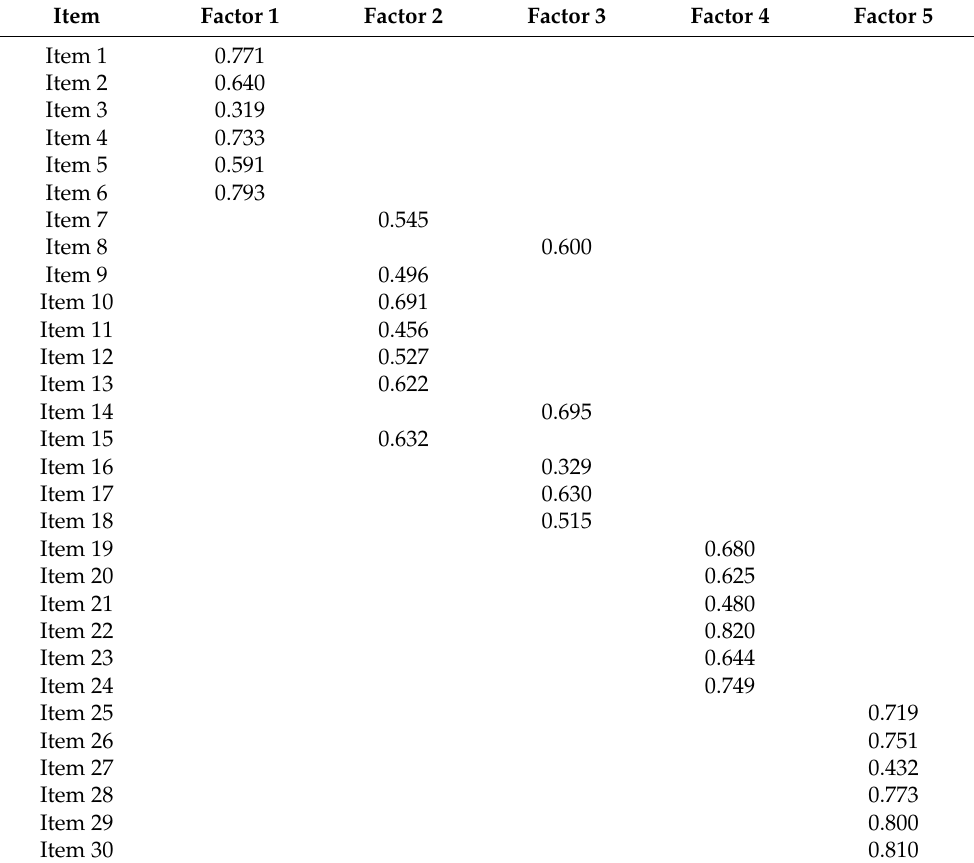
Figure 1. Sedimentation graph of the SSS-W-E. Table 4. Rotated component matrix. Principal component analysis (Varimax).